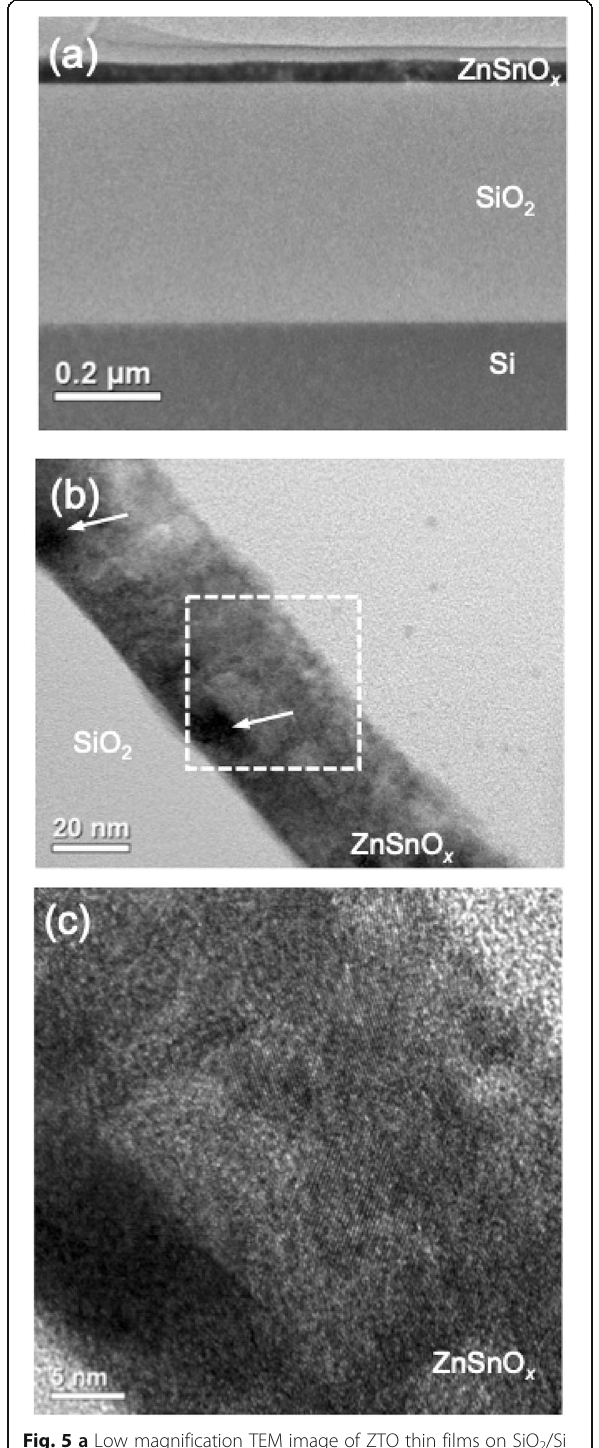
Fig. 5 a Low magnification TEM image of ZTO thin films on SiO 2 /Si substrate. The film is grown in uniform thickness of 40 nm. b TEM image of ZTO film. Some dark contrast regions are observed near the film/substrate interface. c High magnification image of ZTO film, showing some nanocrystalline